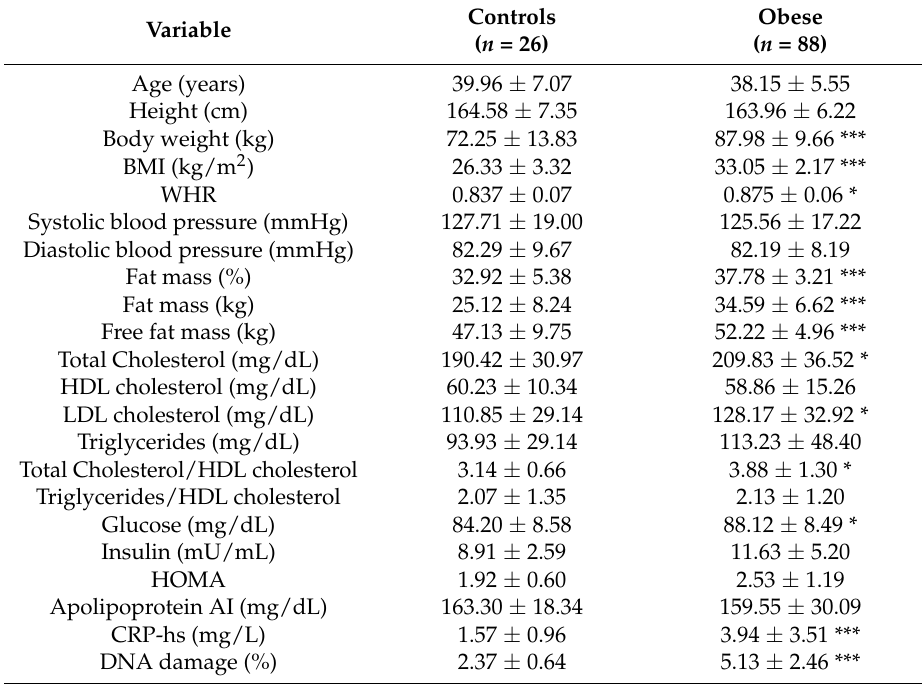
Table 1. Characteristics of the study